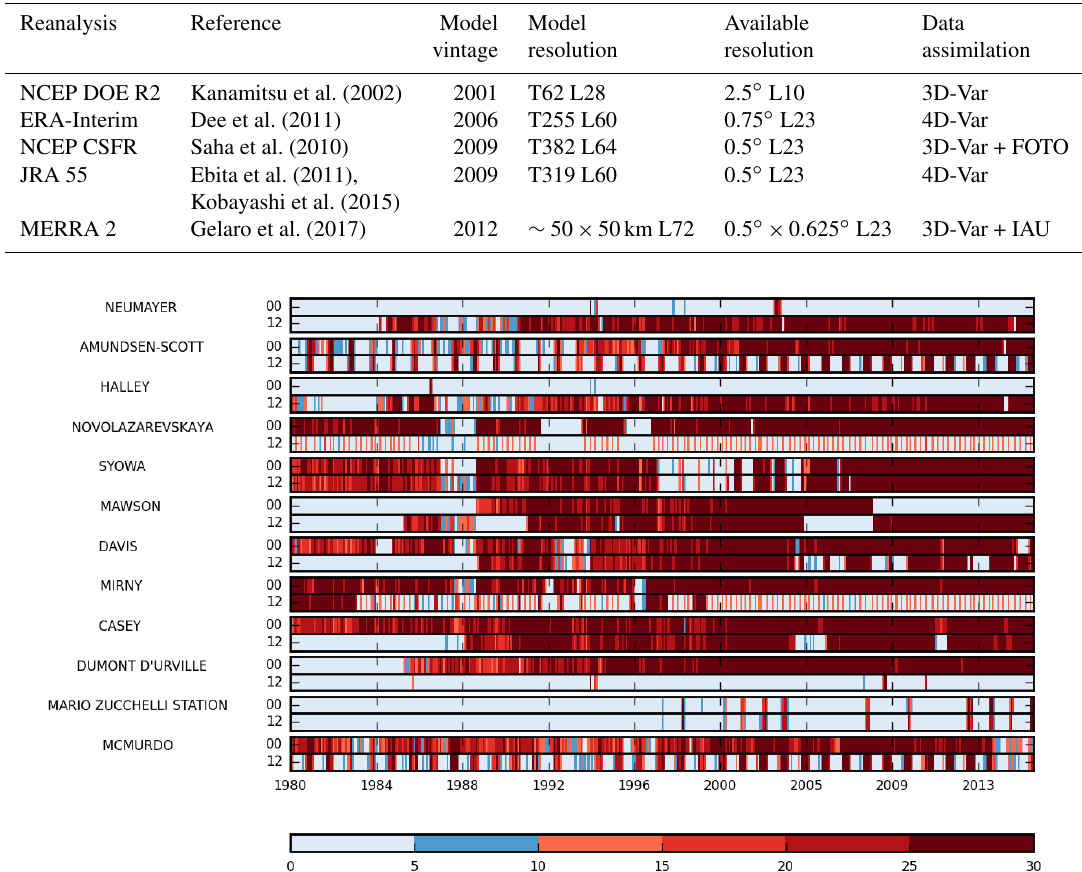
Table 1. Major characteristics of reanalyses compared during the study.